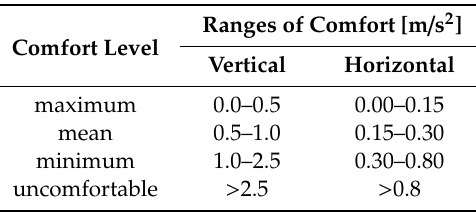
Table 2. Ranges of comfortable use